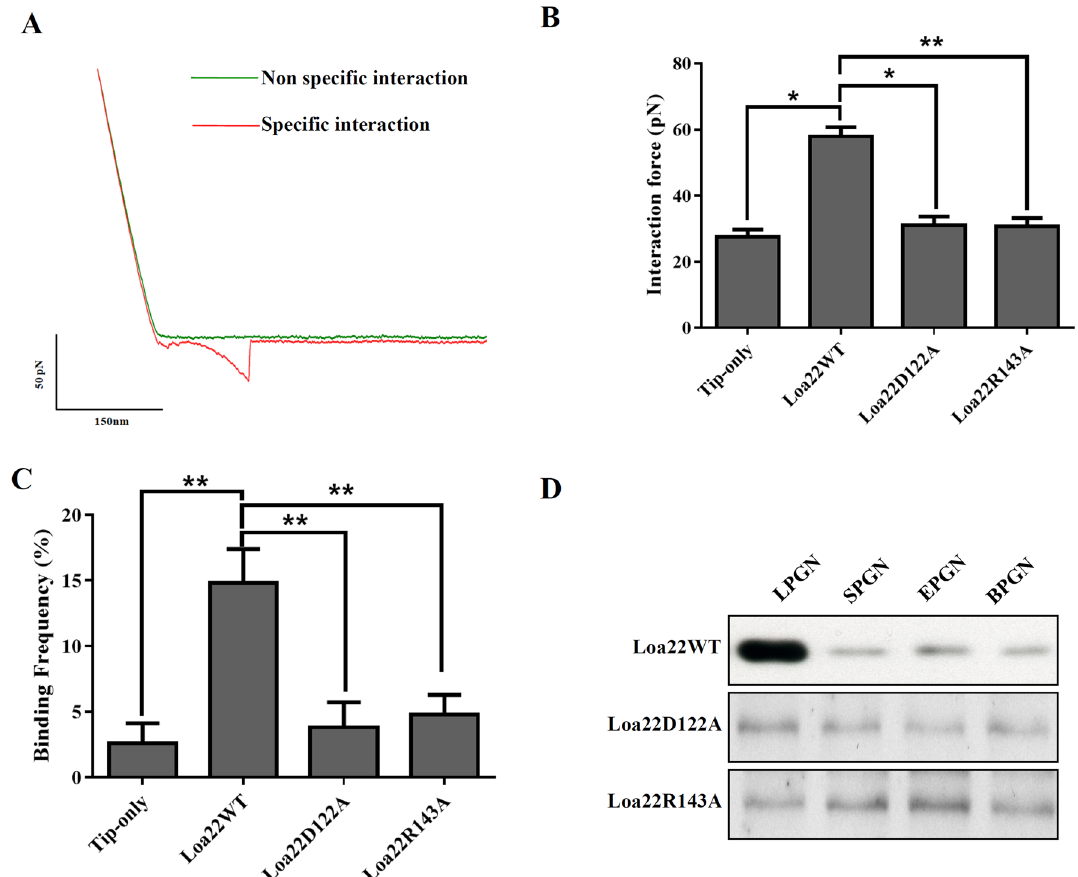
Figure 2. Rupture forces between rLoa22 and cell wall from L. santarosai surface as determined by smAFM. ( A ) The force-distance curves of AFM measurement. The tip-only were used to analyze the interaction to L. santarosai cell wall (green line). rLoa22 modified AFM tip were used to analyze the interaction to L. santarosai cell wall (red line). ( B ) The interaction forces of rLoa22 and its variants interacted with Leptospira cell wall. ( C ) The binding frequency of rLoa22WT and its variants interacted with Leptospira cell wall. rLoa22WT and mutation variants, D122A and R143A, were modified on AFM tip for rupture force measurements, respectively. ( D ) The PGN pull-down assay of rLoa22WT and its variants to PGN molecules including the LPGN and commercial available PGN molecules including E. coli (EPGN), S. aureus (SPGN), and B. subtilis (BPGN), respectively. ⃰ p < 0.05; ⃰ ⃰ p <